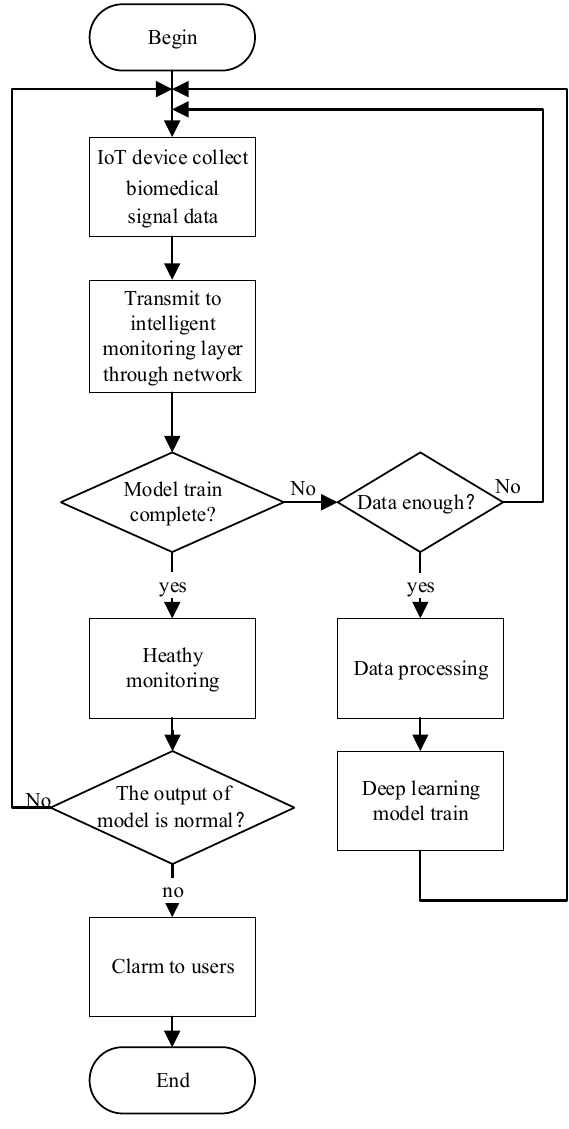
Figure 2. The workflow of biomedical signal intelligent real-time monitoring.